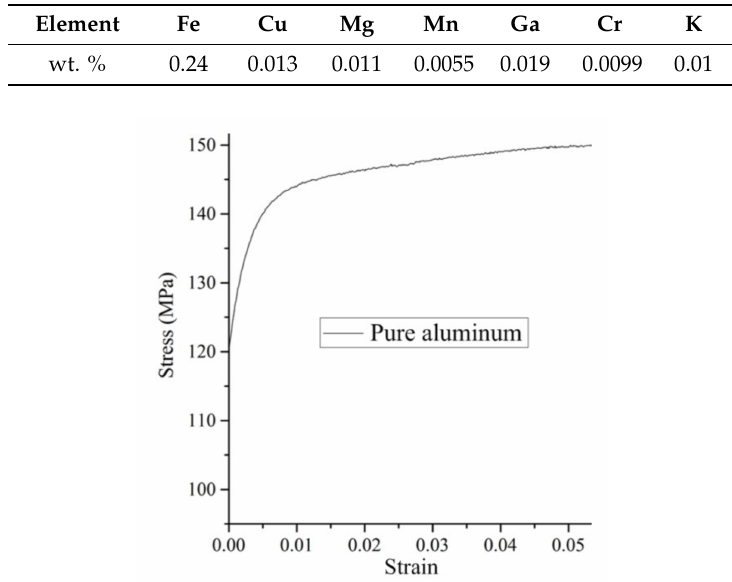
Table 1. Chemical composition of the main impurities of a pure aluminum sheet.